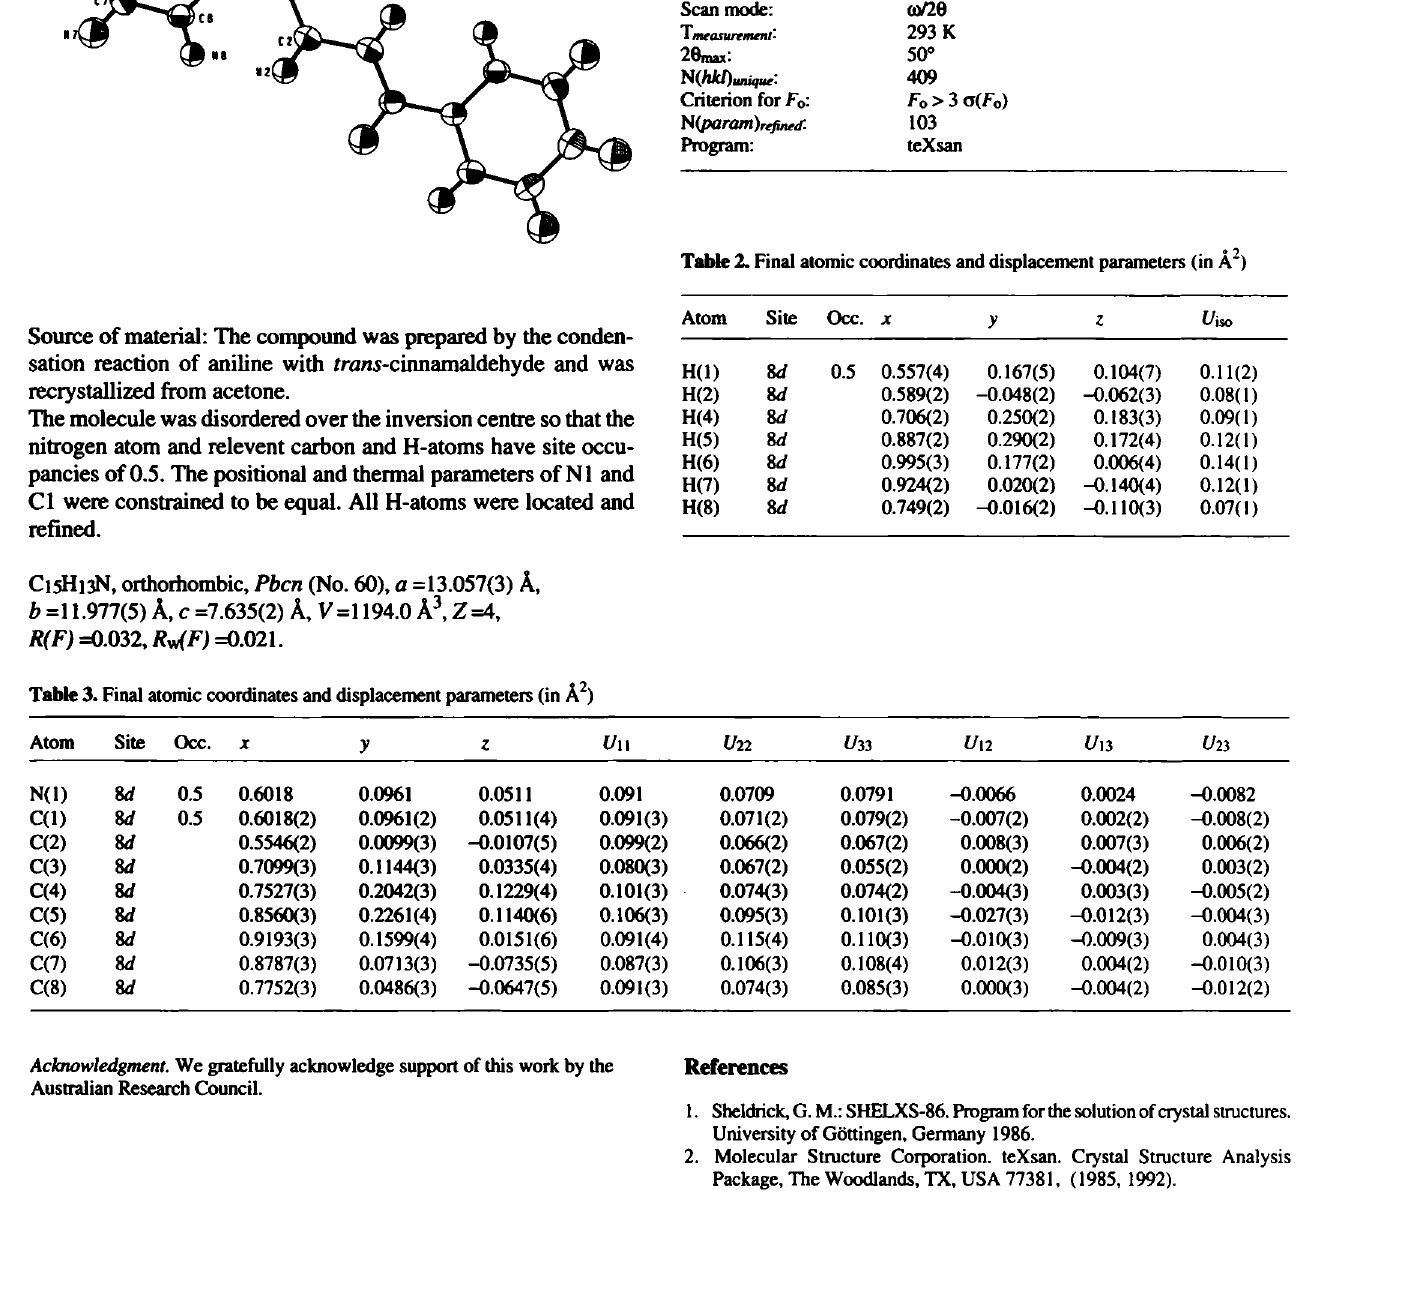
Table 2. Final atomic coordinates and displacement parameters (in Á )